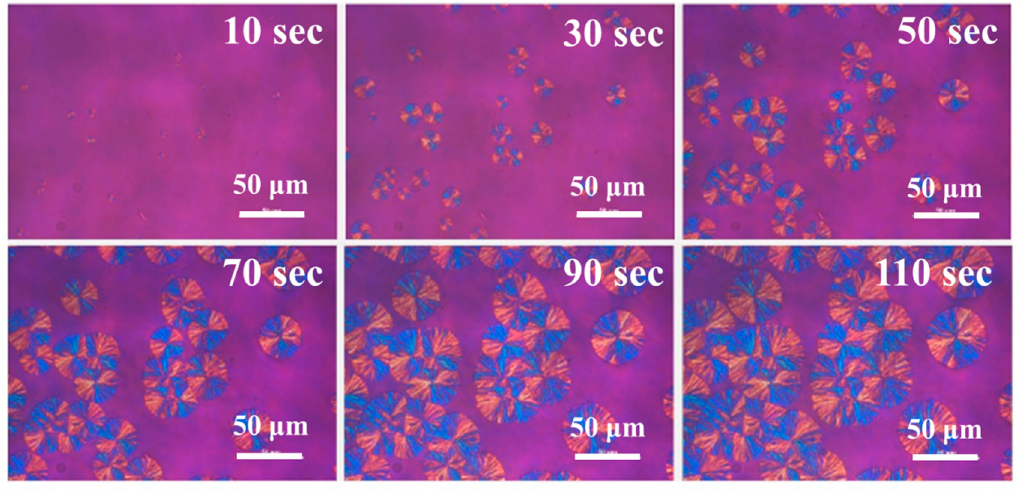
Figure 13. Spherulite growth rates as a function of crystallization temperature for PBT and PBT- co - PTMEG copolymers. 4. Conclusions A series of PBT- co -PTMEG copolymers with PTMEG ranging from 0 to 40 wt% were synthesized via melt polymerization. The structure and composition were designated by 1 H-NMR and FT-IR. PBT- co -PTMEG copolymers retain excellent thermal stability at a T d-5% around 370 °C. However, the T c and Δ H c decreased from 182.3 to 135.1 °C and 47.0 to 22.1 J g − 1 with PTMEG content from 0 to 40